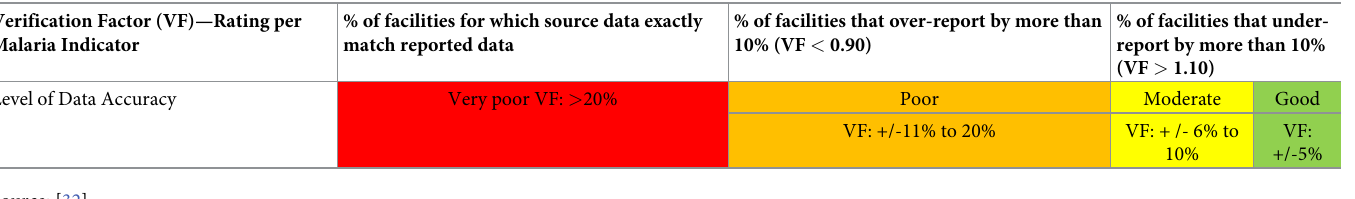
% of facilities for which source data exactly match reported